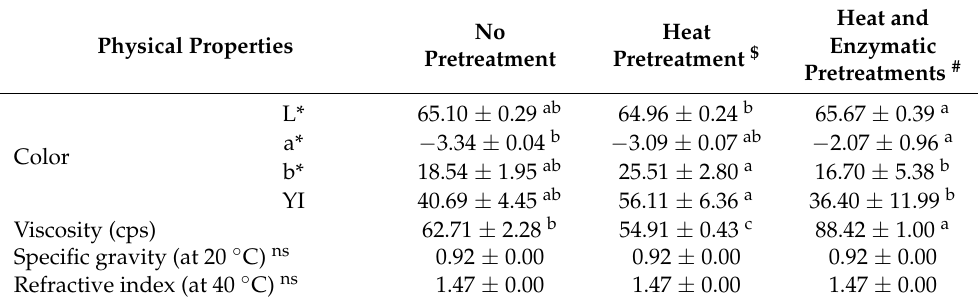
Table 4. Physical properties of H. heteroclita seed oils under different mechanical extraction pretreat- ment